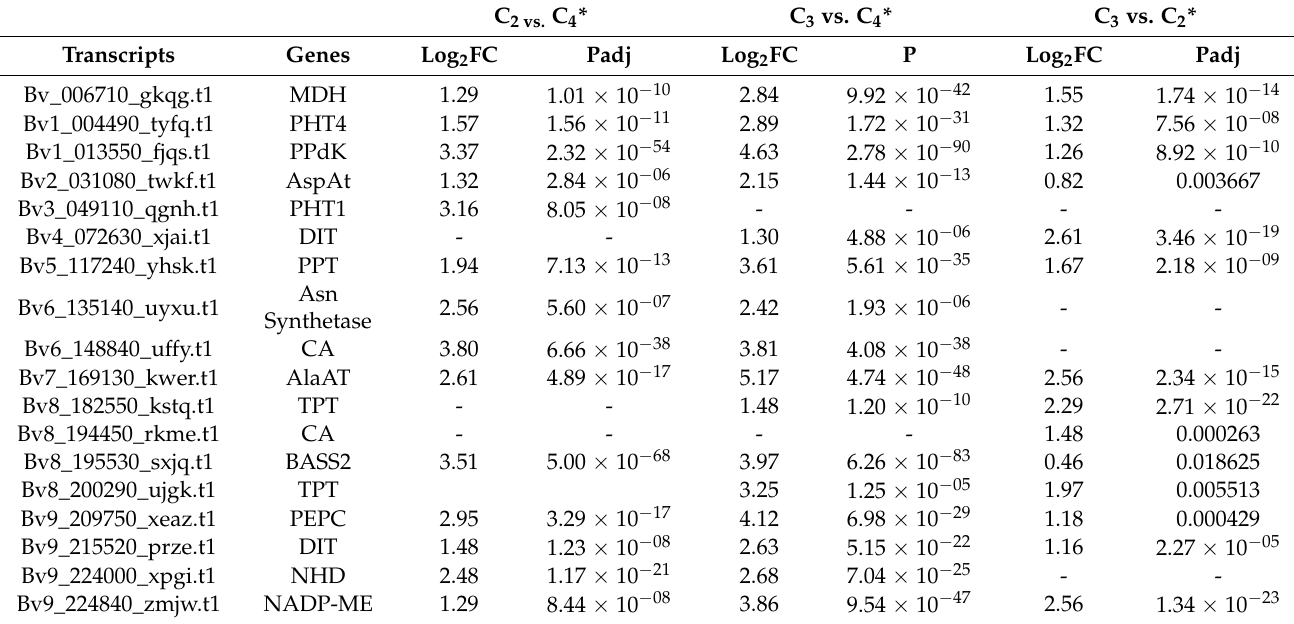
Table 1. Differential expression of C 4 -related enzymes in leaves of Camphorosmeae species. T. diffusa (C 3 ), Sed. sedoides (C 2 ), B. prostrata (C 4